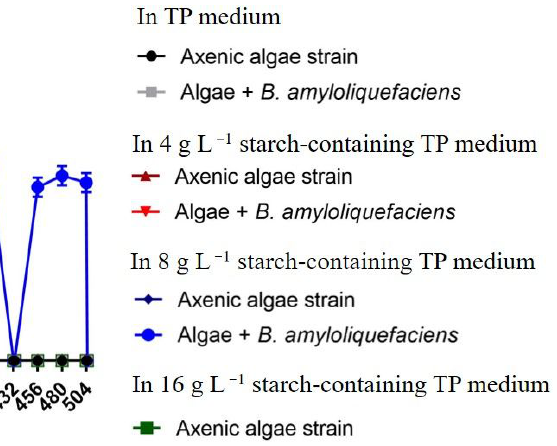
Figure 4. Chlorella sp. MACC-360 cultivation in TAP ( a ) and TP ( b ) media supplemented with 8 g L − 1 starch (the initial bacterial OD 600 of 0.07). Axenic and co-cultured algae are shown. Images were taken on the 7th day of growth.